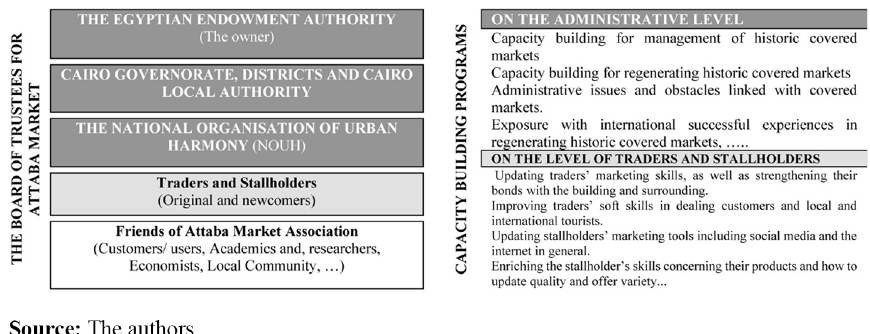
Figure 6. The board of